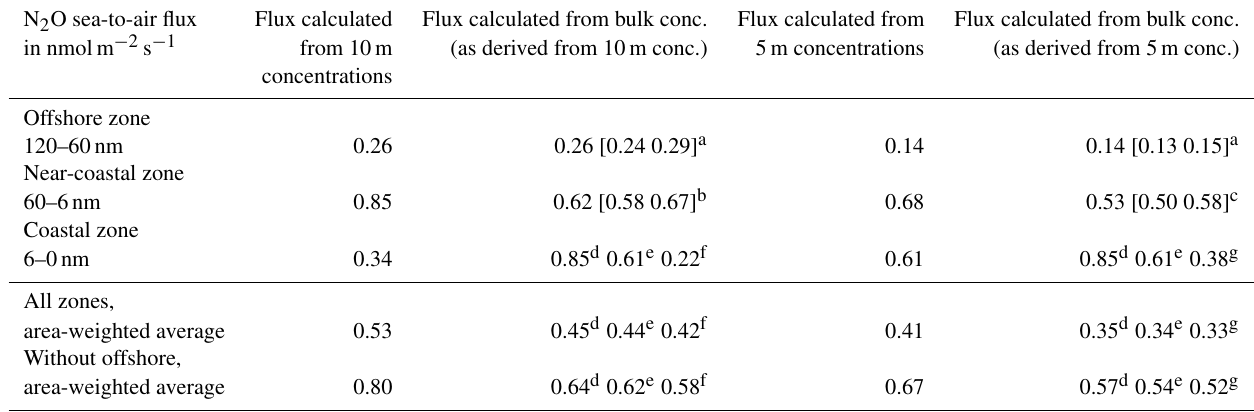
Table 1. Estimated average emission rates of N 2 O for December 2012 in different zones of the Peruvian upwelling region. Comparison between fluxes calculated from 10m, 5m, and surface (bulk)